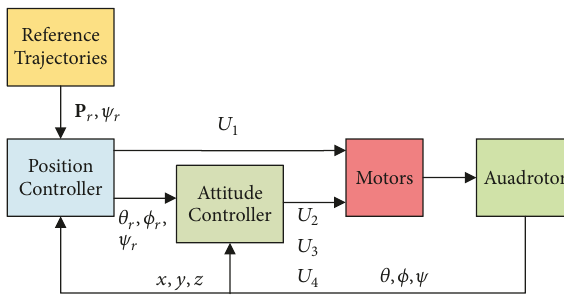
Figure 3: Control system architecture of the